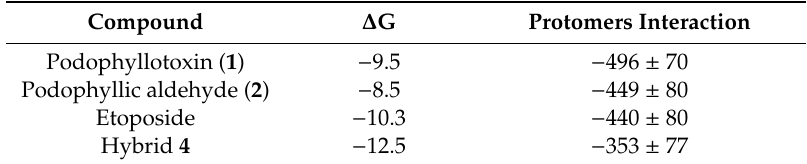
Docking energies (kcal / mol) calculated for compounds 1 , 2 , 4 and etoposide for tubulin